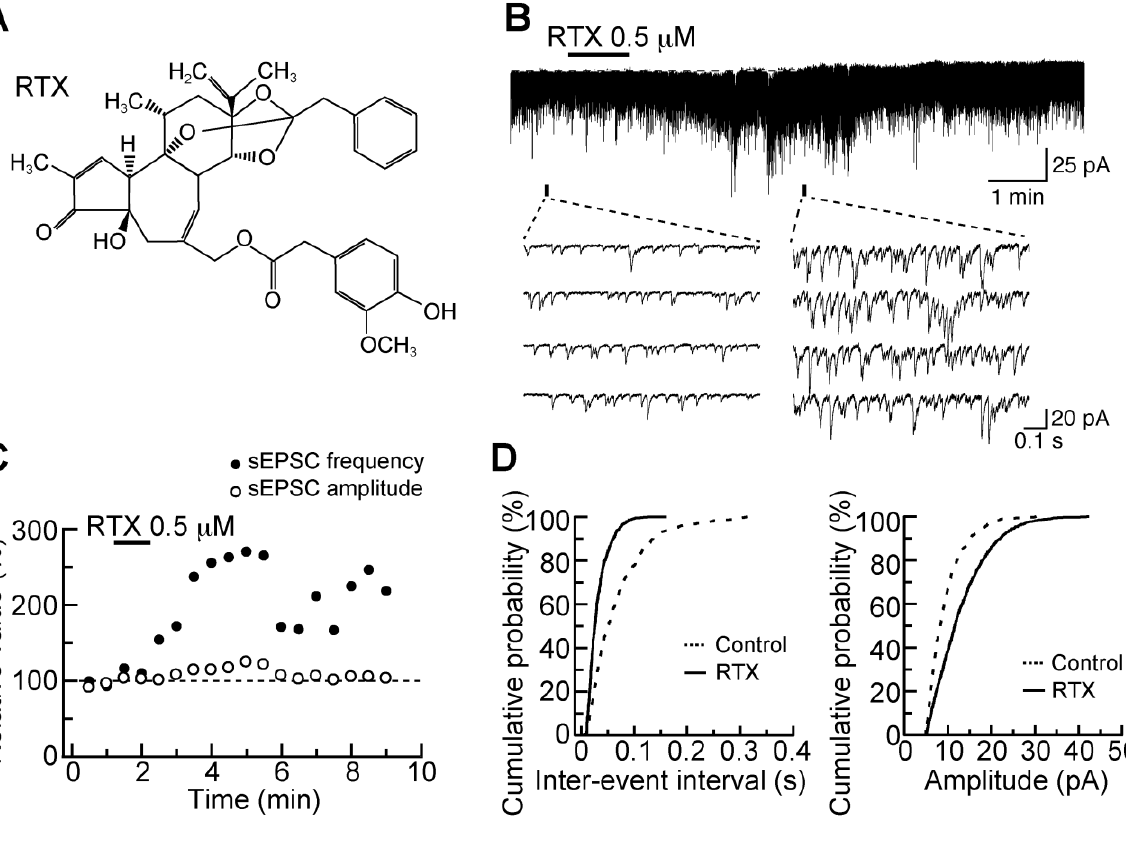
Figure 5. Resiniferatoxin (RTX; 0.5 µM) superfused for 1 min increases the frequency of sEPSC with a small increase in its amplitude in rat SG neurons. ( A ) The chemical structure of RTX; ( B ) Recordings of sEPSCs in the absence and presence of RTX. RTX produces a small peak inward current of 3.5 pA; ( C ) Changes in sEPSC frequency and amplitude (closed and open circles, respectively) were measured every 0.5 min (frequency and amplitude before RTX application: 15.0 Hz and 12.1 pA, respectively); ( D ) Cumulative histograms of the amplitude and inter-event interval of sEPSC before RTX application (Control; dotted line) and under the action of RTX (continuous line). The histograms were examined for 0.5 min in the control (435 sEPSC events) and 3 min after RTX washout (947 sEPSC events). RTX shifted the inter-event interval and amplitude distributions to shorter and larger ones, respectively ( p < 0.01; Kolmogorov-Smirnov test); ( B – D ) were obtained from the same neuron. V = −70 mV. Modified from [65] with permission of H Elsevier